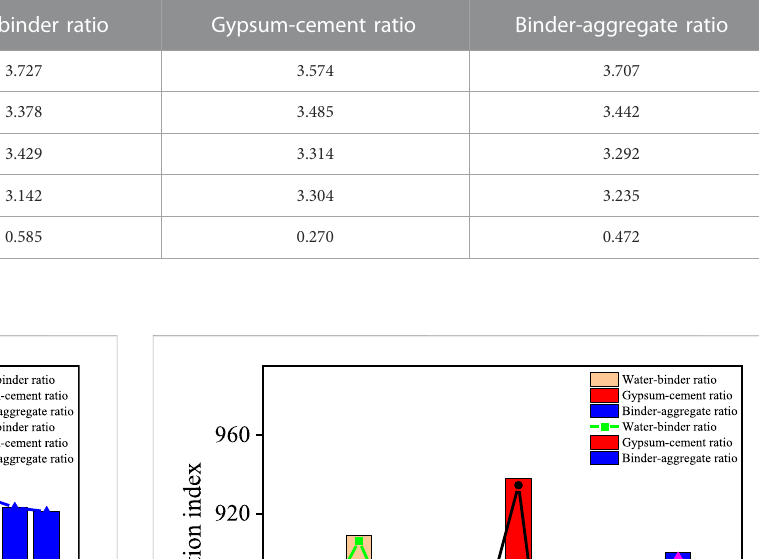
TABLE 9 Range analysis of longitudinal wave velocity (km/s).